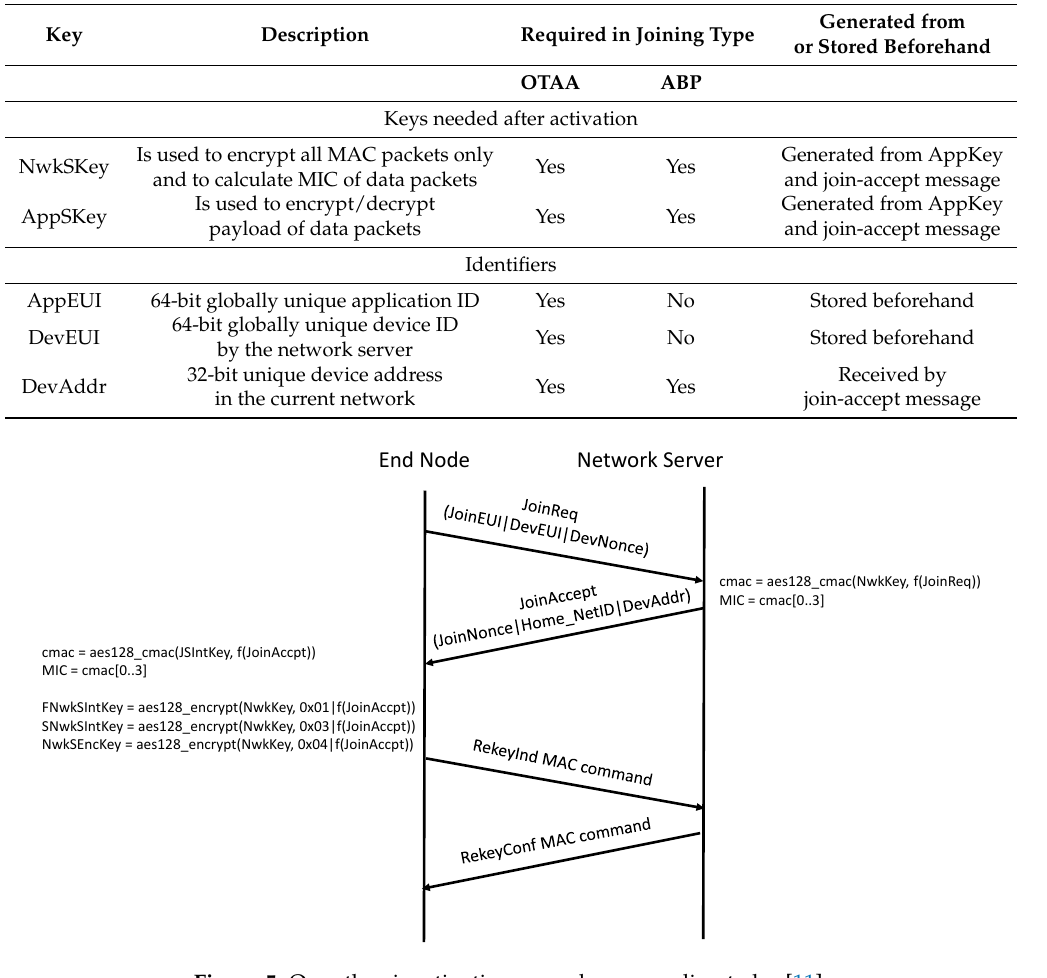
Figure 5. Over the air activation procedure according to lor